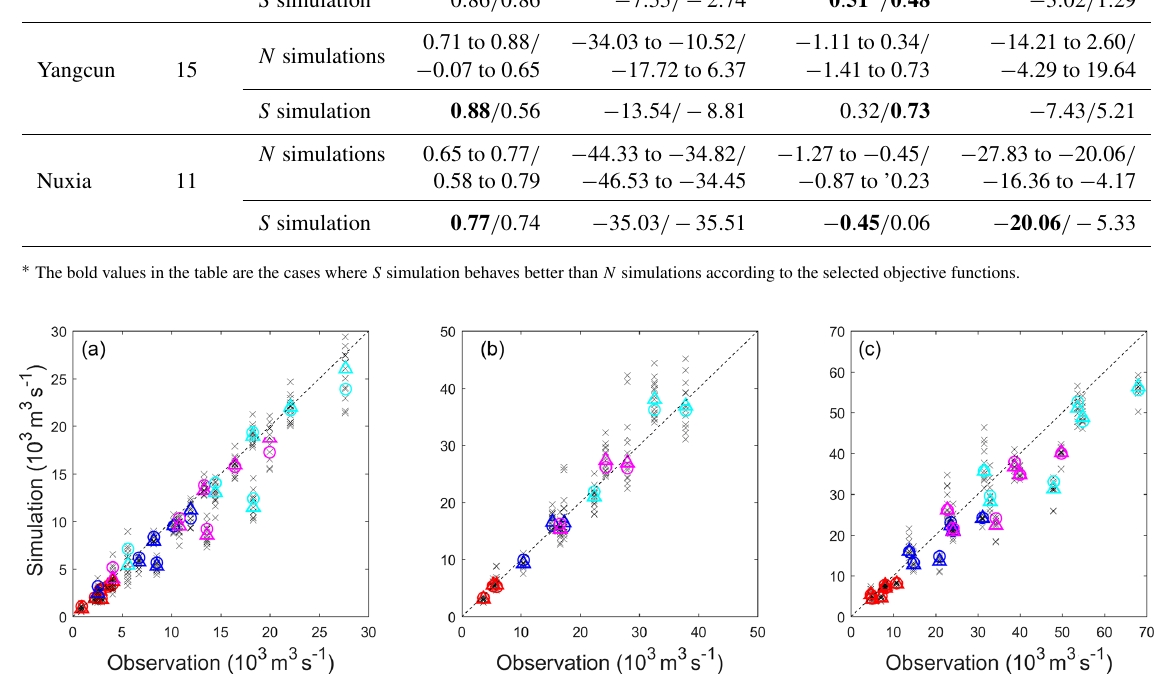
Figure 4. Typical simulated flood volumes versus observed ones. The crosses in the figures are results by N simulations, and triangles are median values of N simulations. Circles are results from S simulation. The different colors are volumes for different durations: red is for Q 1 , blue is for Q 3 , and magenta and cerulean are for Q 5 and Q 7 . (a) Nugesha. (b) Yangcun. (c)